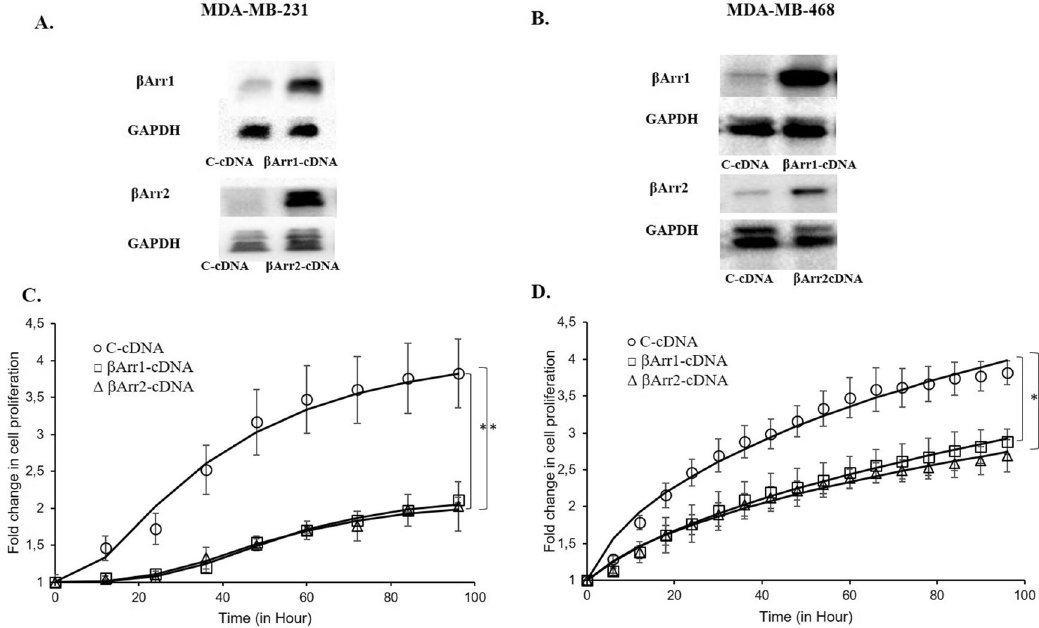
Figure 4. Overexpression of βArr1 or βArr2 and decreased cell proliferation. The expression level of βArr1 or βArr2 was increased by transfecting βArr1 or βArr2-cDNA to MDA-MB-231 or MDA-MB-468 cells and ( A ) and ( B ) show a significant increase in the level of these proteins determined by Western-blot analysis. ( C ) and ( D ) show impedance measurement of cell proliferation with real time cell electronic sensing system in C (control)-, βArr1-, or βArr2-cDNA transfected MDA-MB-231 and MDA-MB-468 cells. Cell proliferation was recorded continuously just after seeding cells. The cell proliferation after four hours was defined as the baseline and the fold change of the baseline was determined for further measurements and shown as the fold change in cell proliferation in C and D. Overexpression of βArr1 or βArr2 significantly inhibited the cell proliferation in both cell lines. Data are presented as mean ± standard error of the mean; n = 4–5; * = p < 0.05 versus